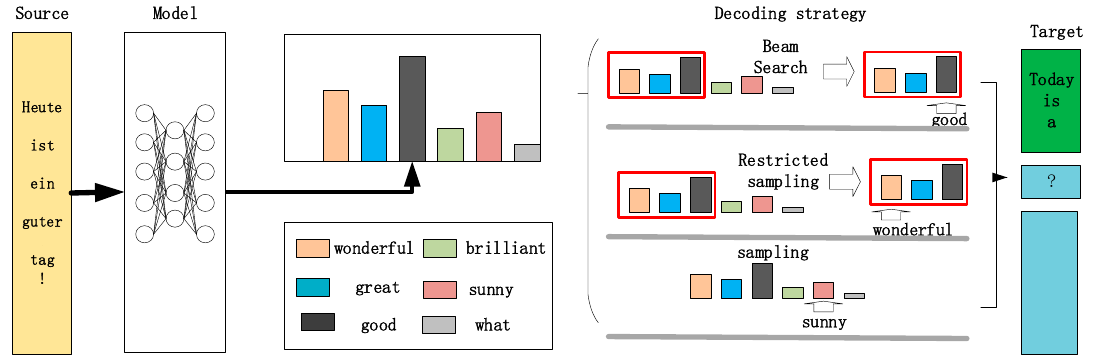
Figure 1. The difference of three decoder strategies: beam search, sampling, and restricted sampling. Figure 1. The di ff erence of three decoder strategies: beam search, sampling, and restricted